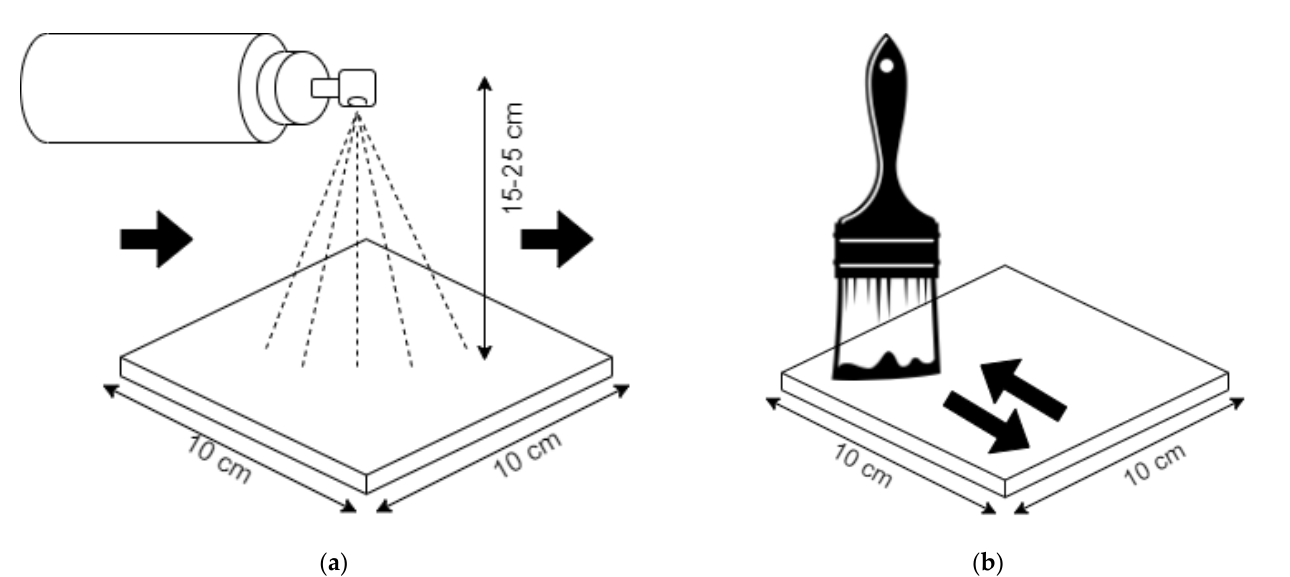
Figure 1. Scheme of coatings application type: ( a ) spray type; ( b ) brush type.